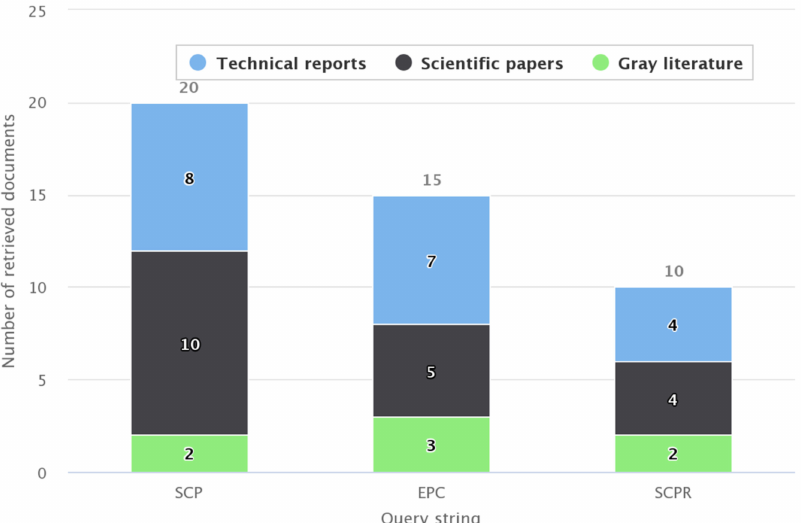
Figure 3. The x-axis represents the query strings: Small-scale Coffee Production (SCP), Economic Coffee Profitability (ECP), and Small-scale Coffee Profitability (SCPR). The y-axis represents the number of documents retrieved the colors blue, black, and green represent technical reports, scientific papers and grey literature. The documents retrieved are shown by the query strings, quantity, and type of